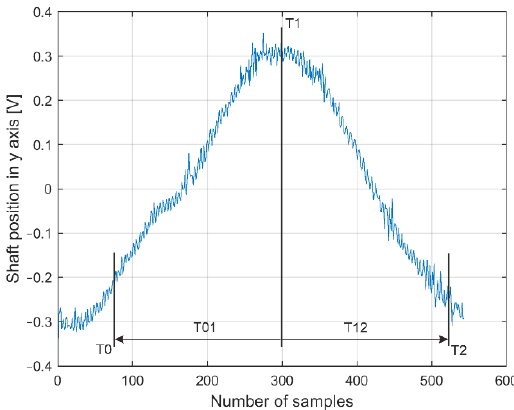
Figure 1. Dividing the signal into two sub-periods T 01 and T